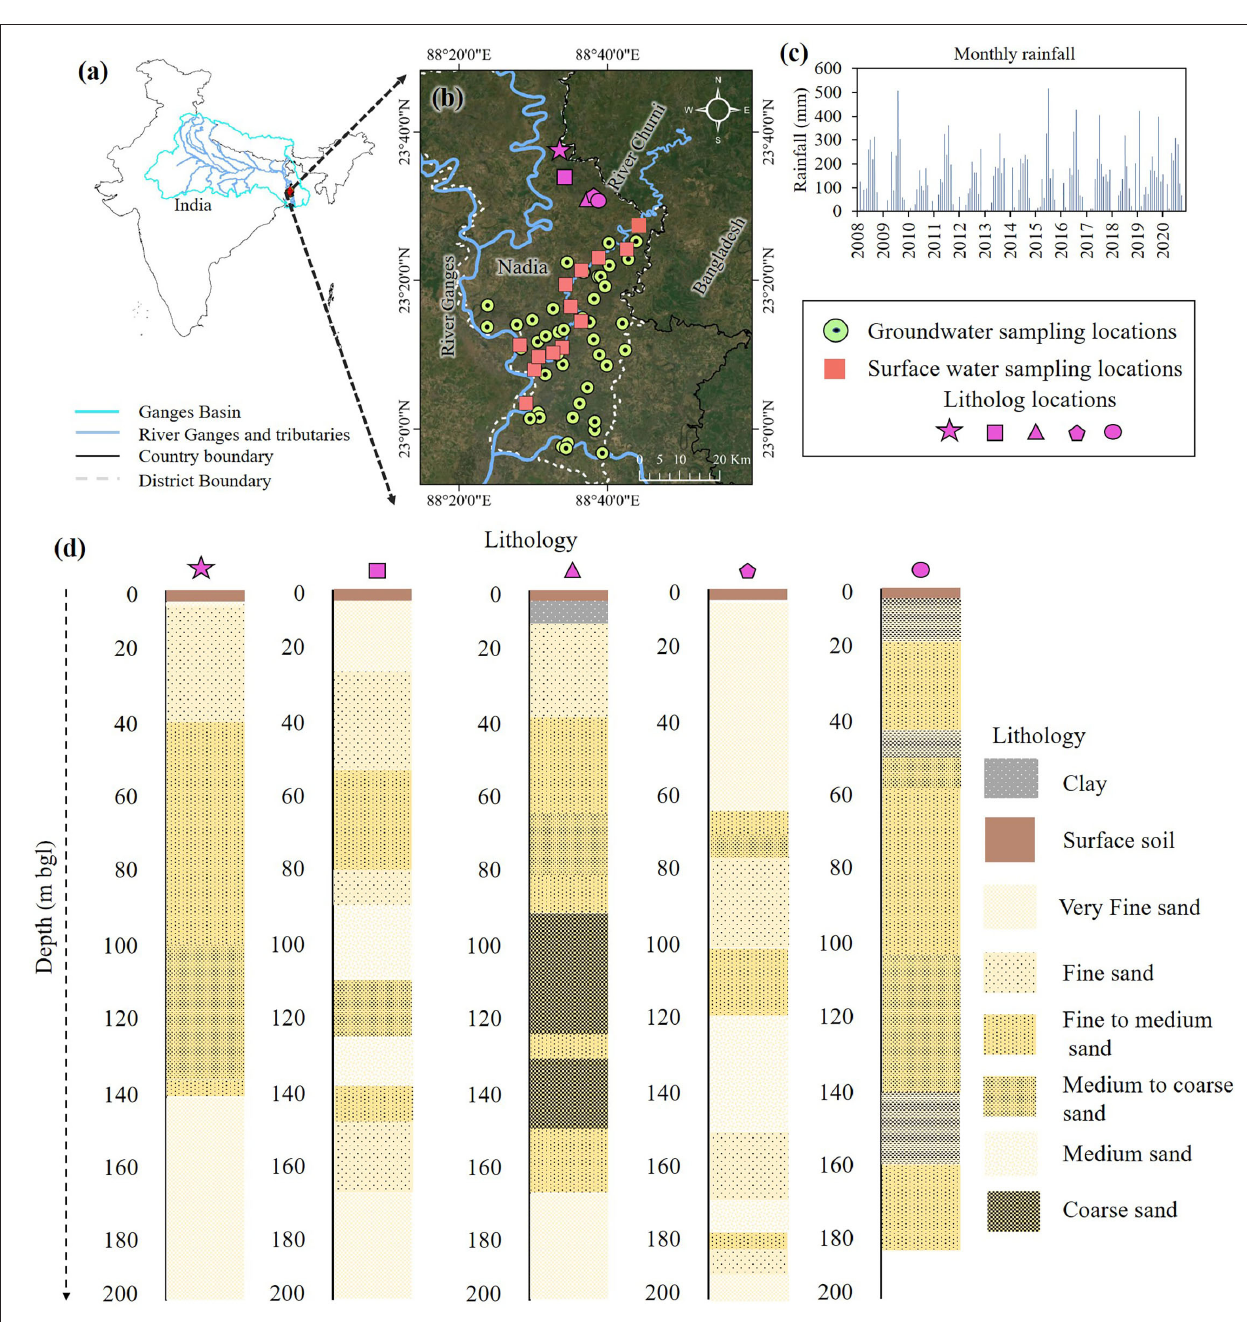
FIGURE 1 | Study area map showing sampling locations of groundwater and river water. (a) Map of India showing Ganges basin and location of Nadia district, (b) Aerial view of study area map (GeoEye-2) showing sampling locations, (c) Monthly rainfall of last 12 years (Indian Meteorological Department, 2022), and (d) Lithological cross section of respective study